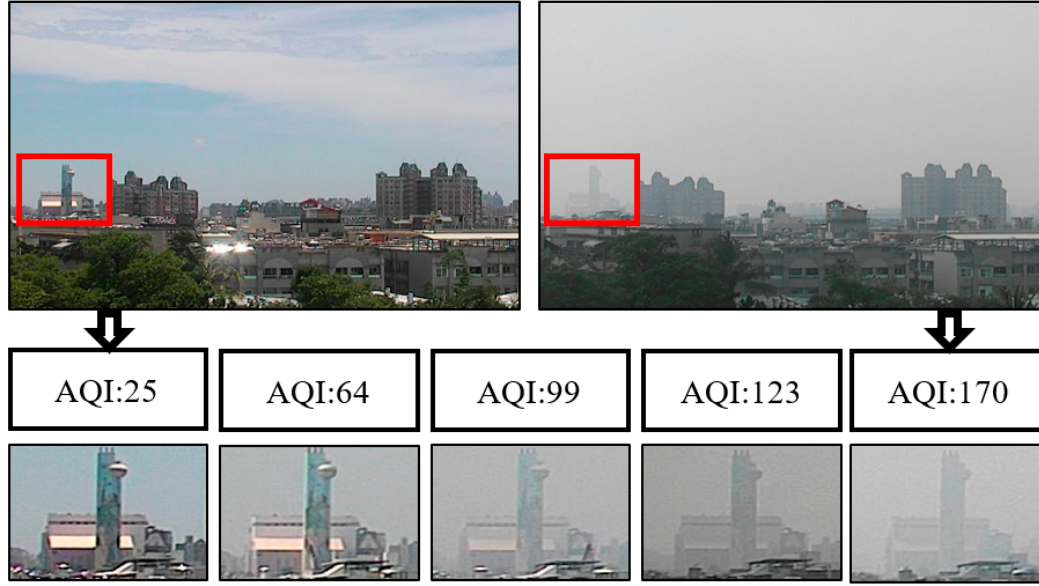
Figure 1. A schematic diagram of AQI and visibility changes.